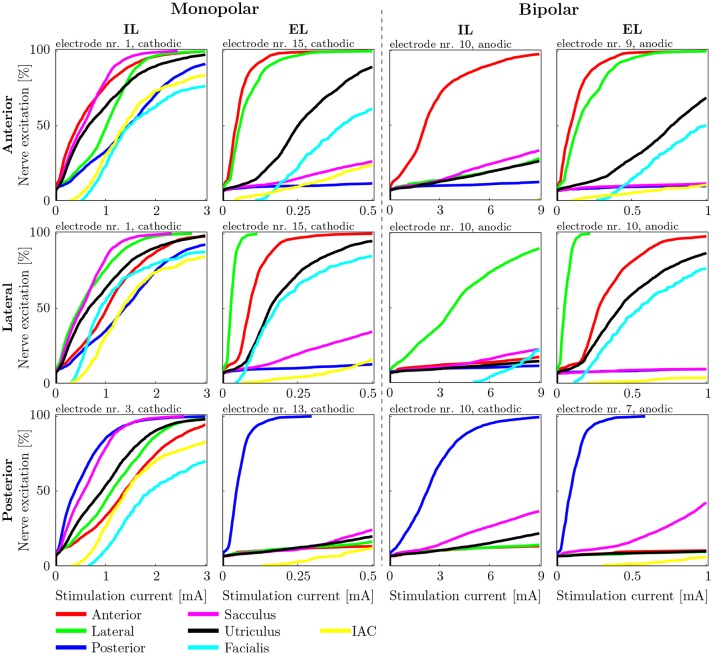
Recruitment curves of the electrodes with the highest AUC values during stimulation of the anterior (Top), the lateral (Central), and the posterior (Bottom) ampullary nerves. The four columns depict the different IL and EL, monopolar and bipolar electrode configurations. The graphs are labeled on top with the electrode configuration and stimulation polarity which produced the respective recruitment curves.